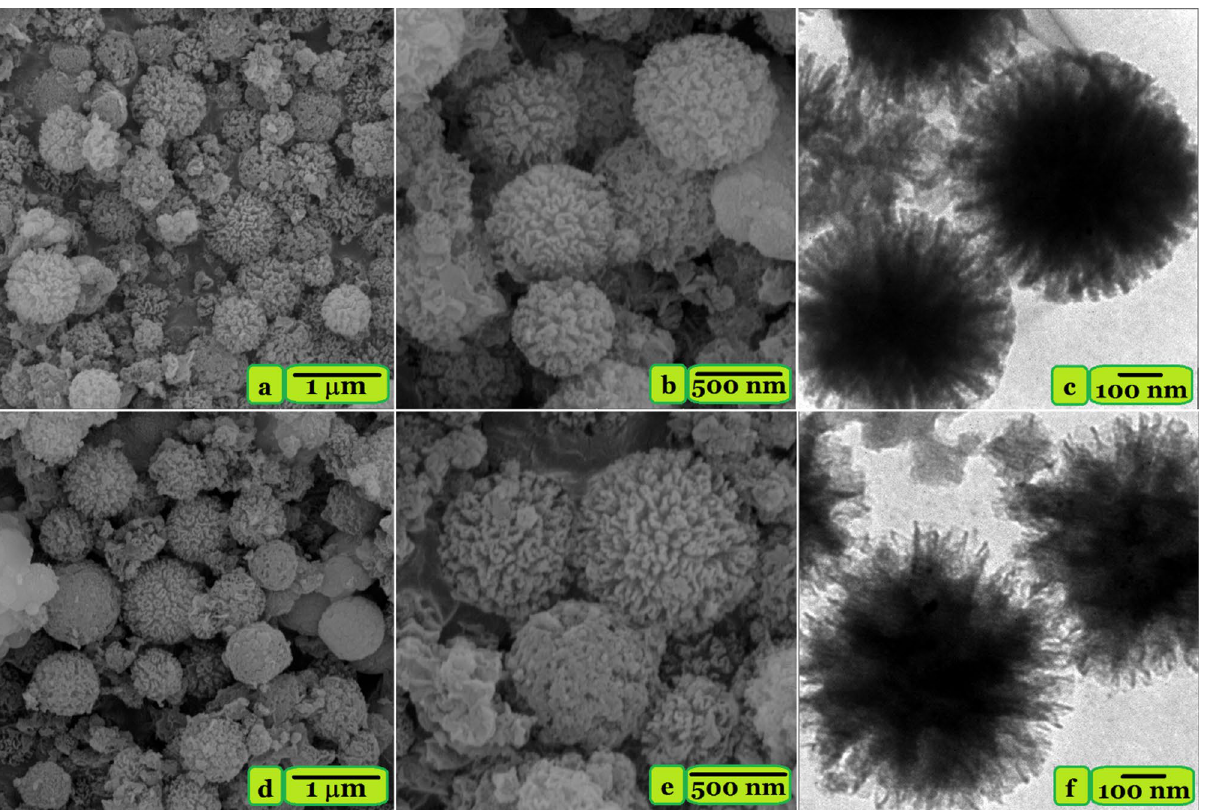
Figure 2. FESEM images of KCC-1 ( a , b ) and TSF-KCC-1 ( d , e ). TEM images of KCC-1 ( c ) and TSF-KCC-1 ( f